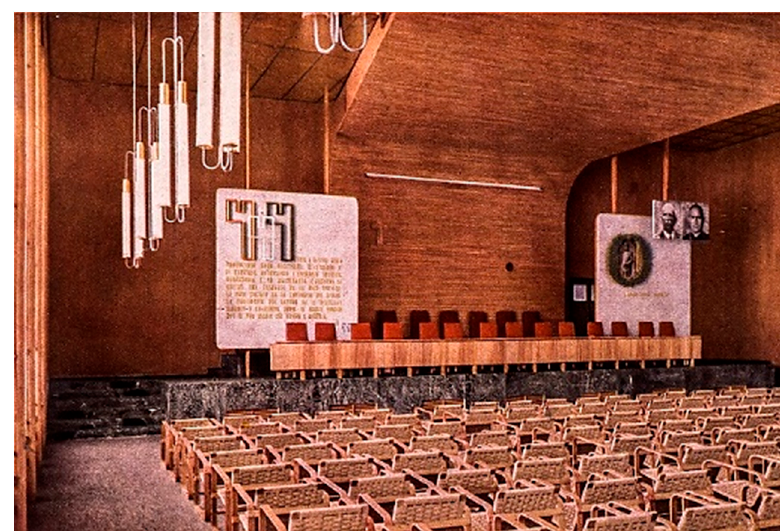
Figure 33. The auditorium with armchairs in curved plywood. Patent of the Maggioni company in